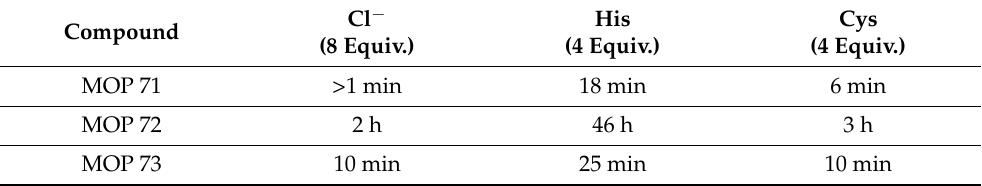
Table 2. Describing the stabilities of MOP 71, MOP 72 and MOP 73 in presence of biologically relevant nucleophiles. Half-lives ( t 1/2 ) for the decomposition of the MOP 71-73 architectures against selected biologically relevant nucleophiles (3:2 DMSO-d 6 /D 2 O, 298 K, 500 MHz) as measured through time-course 1 H NMR